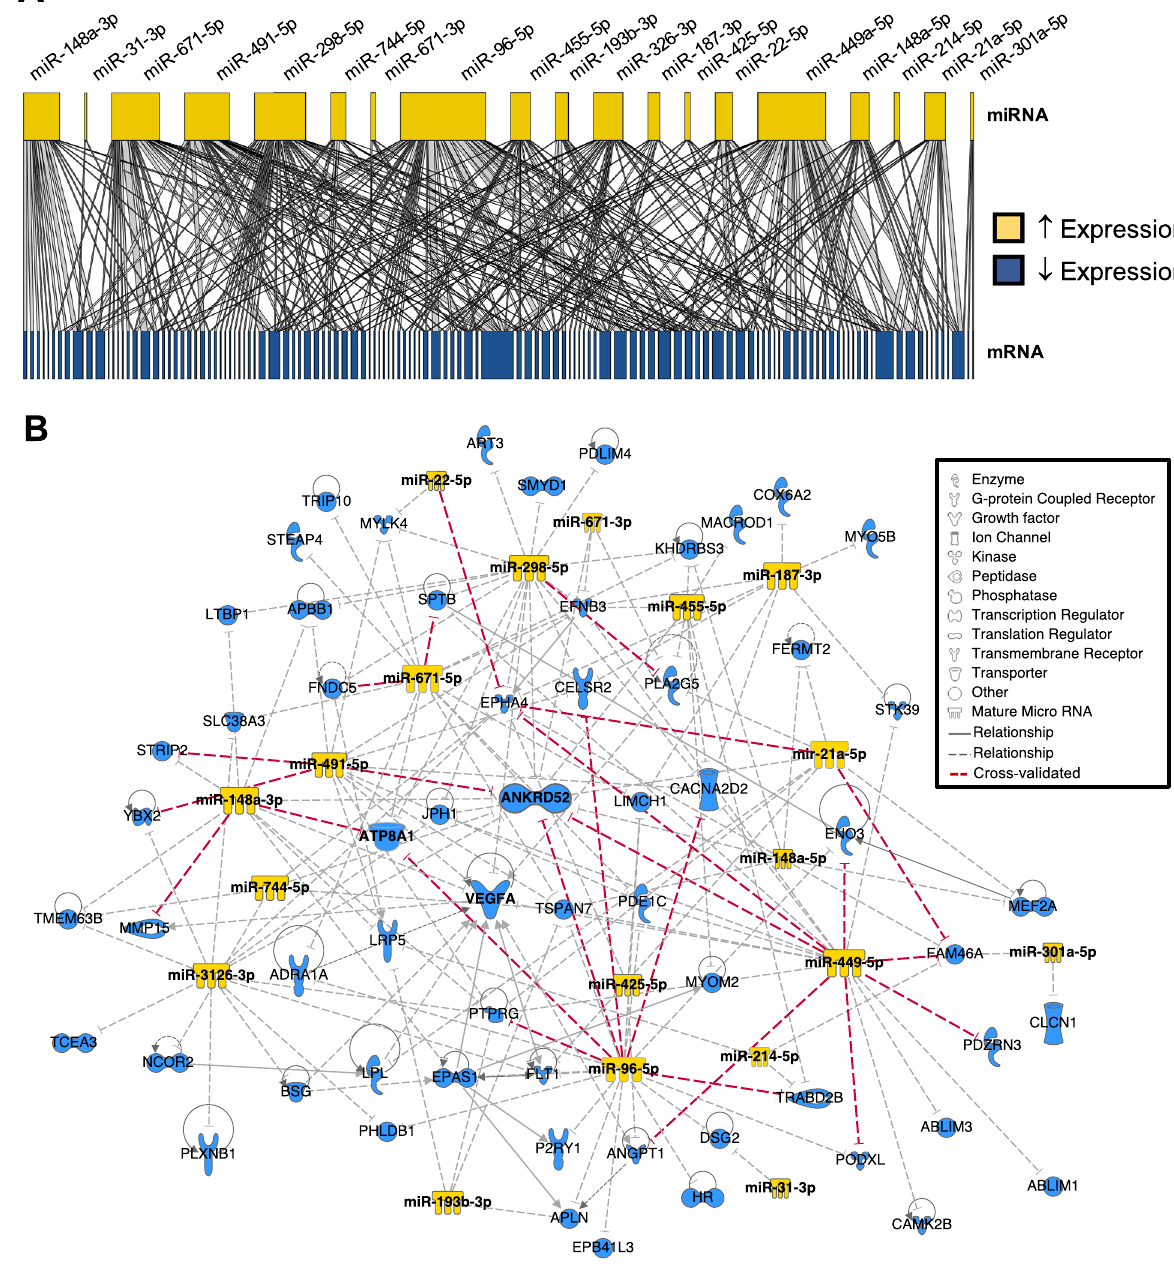
Figure 5. Cardiac miRNA:mRNA Reductive Stress Regulatory Network. ( A ) Bipartite network generated in R (3.4.2) illustrating the complex predicted interaction between ARE-containing induced reductomiRs and suppressed “transgene-dose” effect DEGs, with box-width defined by the relative number of miRNA-mRNA interactions. Line thickness indicates frequency of detection across miRNA target prediction algorithms. ( B ) Ingenuity Pathway Analysis (IPA)-derived signaling network diagram of repressed “transgene-dose” effect DEGs identified as putative downstream targets of ARE-containing DEmiRs. Cross-validated predictions (red dotted lines) using multiMiR (1.12.0) represent miRNA-mRNA interactions predicted by at least 3 independent